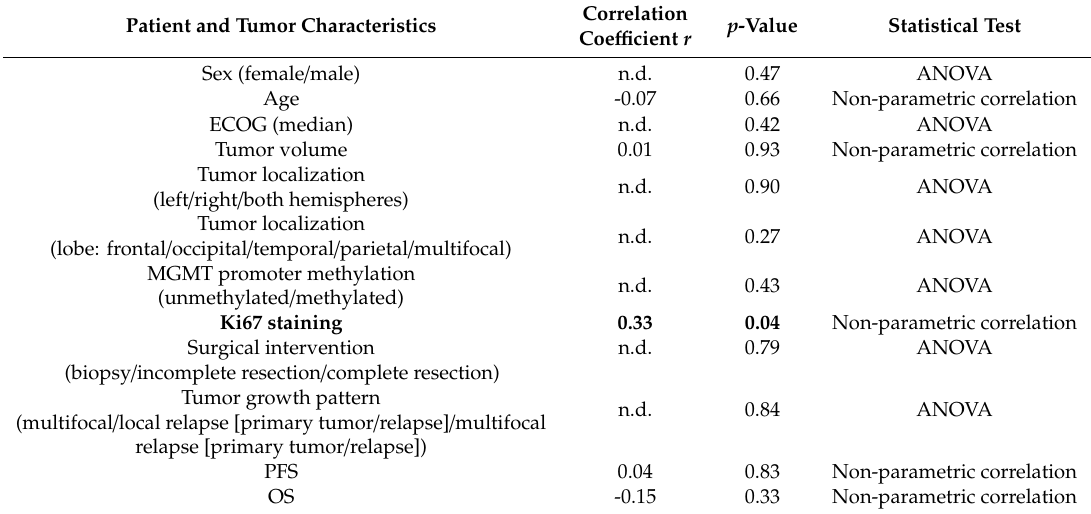
Table 4. Correlation of GBM patient and tumor characteristics with RPS27 mRNA